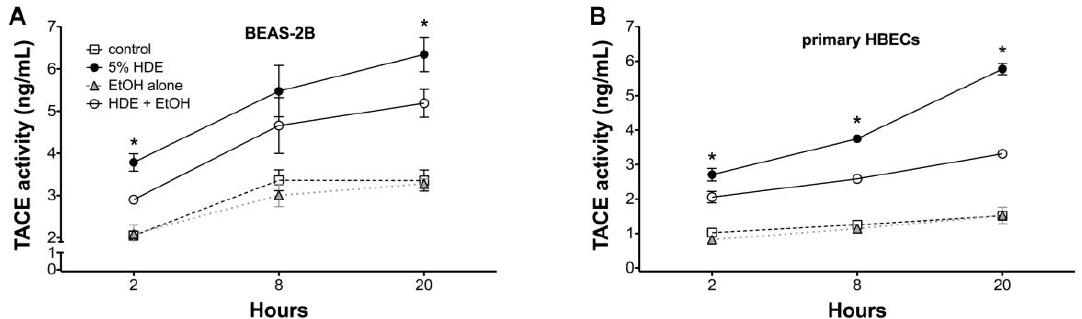
Figure 6. Alcohol pre-treatment inhibits HDE-induced TACE activity in BEAS-2B and primary human bronchial epithelial cells. Lysates from BEAS-2B (panel A ) primary human bronchial epithelial cells (HBECs; panel B ) pretreated with or without 100 mM ethanol for 1 h before exposure to 5% HDE or control medium for an additional 2, 8, or 20 h were assayed for TACE activity. HDE stimulated TACE from 2 to 20 h, but alcohol pretreatment blunted HDE-induced TACE activity at all time points. Data shown represent the means (±SEM) of 3 separate experiments (* p < 0.05 vs. HDE + EtOH).